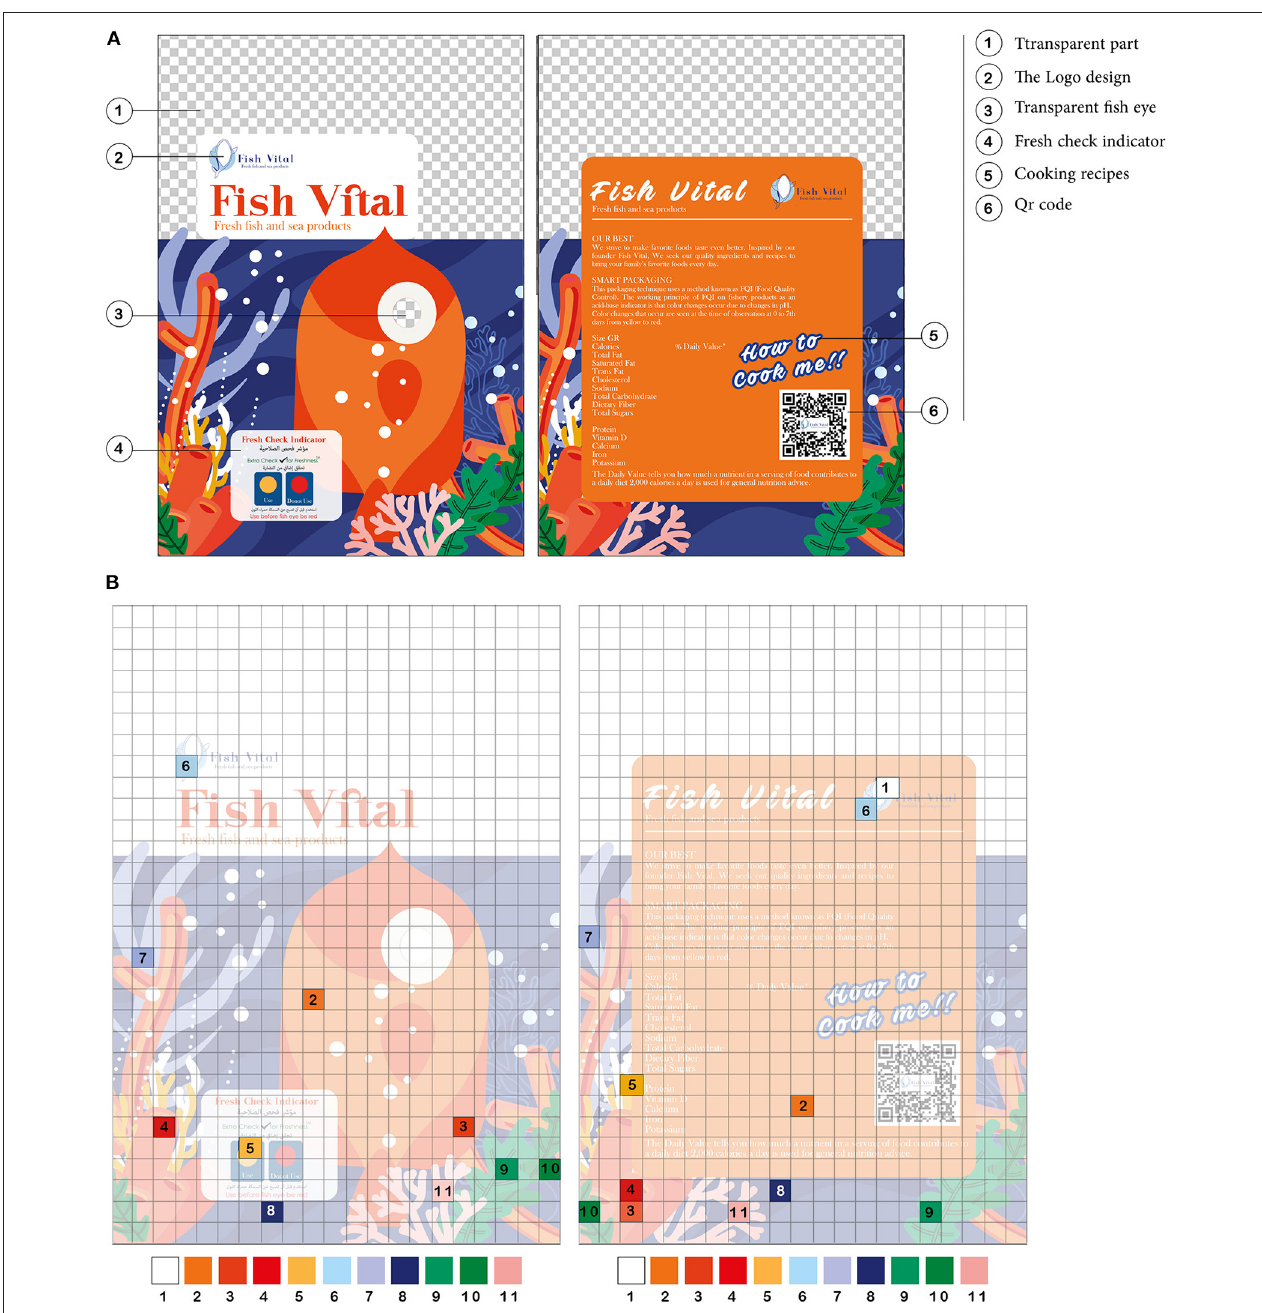
FIGURE 2 | (A) The designed interactive package and (B) the color spot on the package.